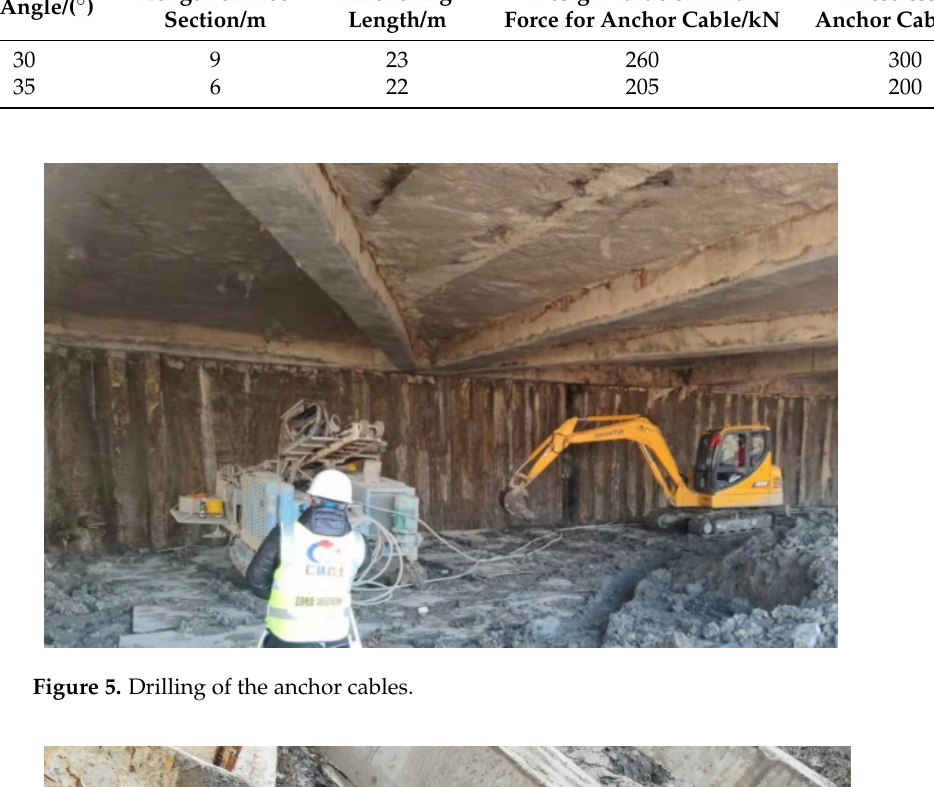
Table 3. Parameters of the anchor cables.